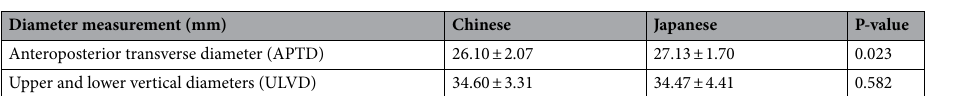
Table 1. Comparison of glenoid parameters in individuals from Chinese and Japanese population CT